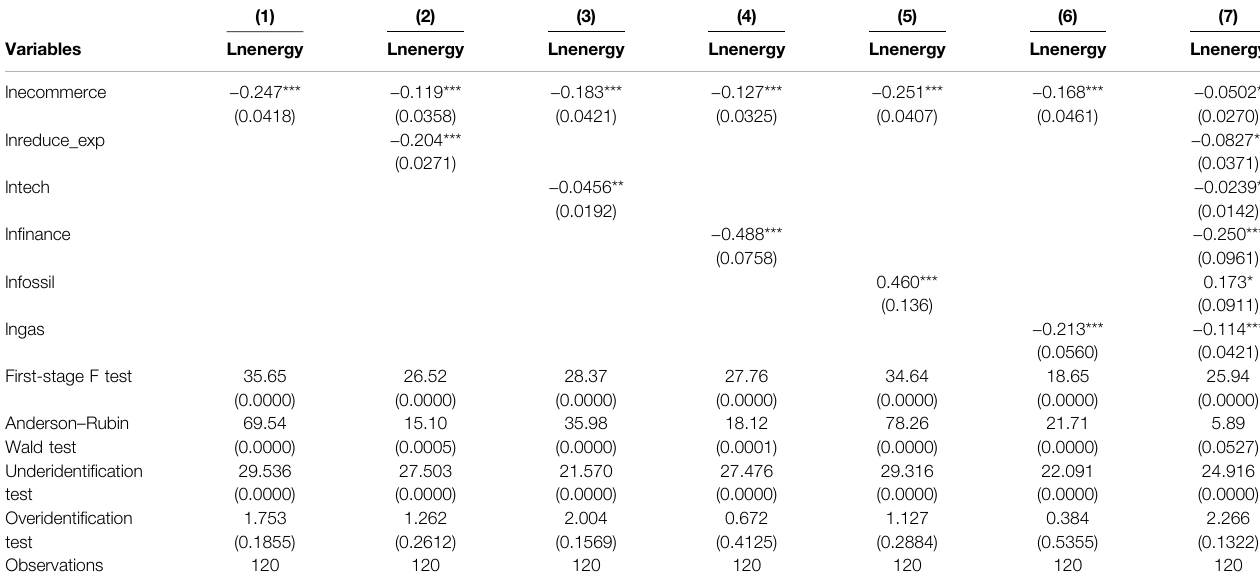
TABLE 6 | Instrumental variables ’ estimation results with panel data